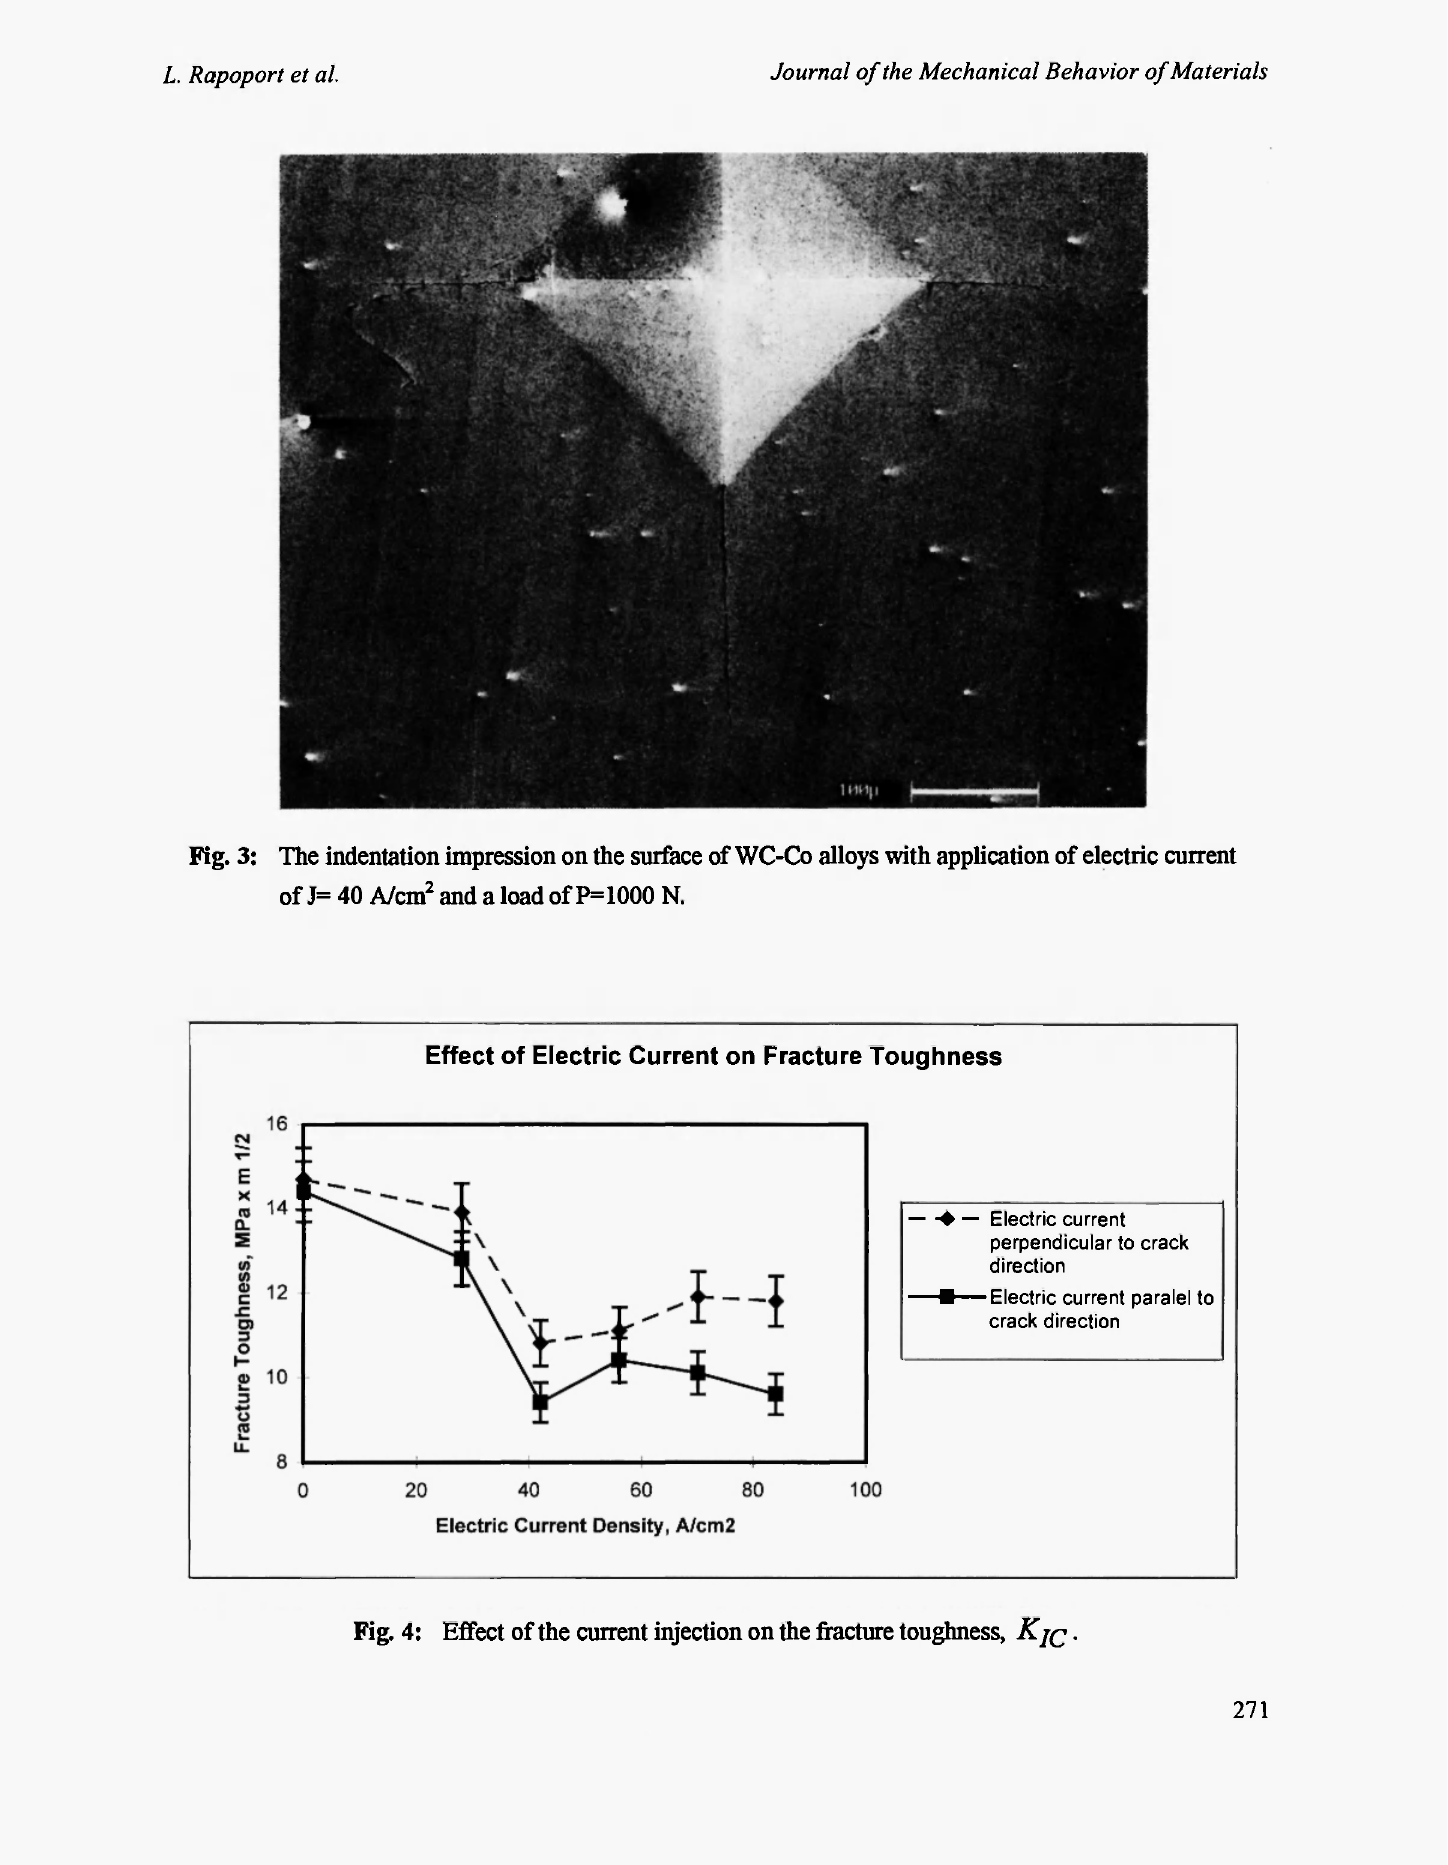
Fig. 4: Effect of the current injection on the fracture toughness, KJQ